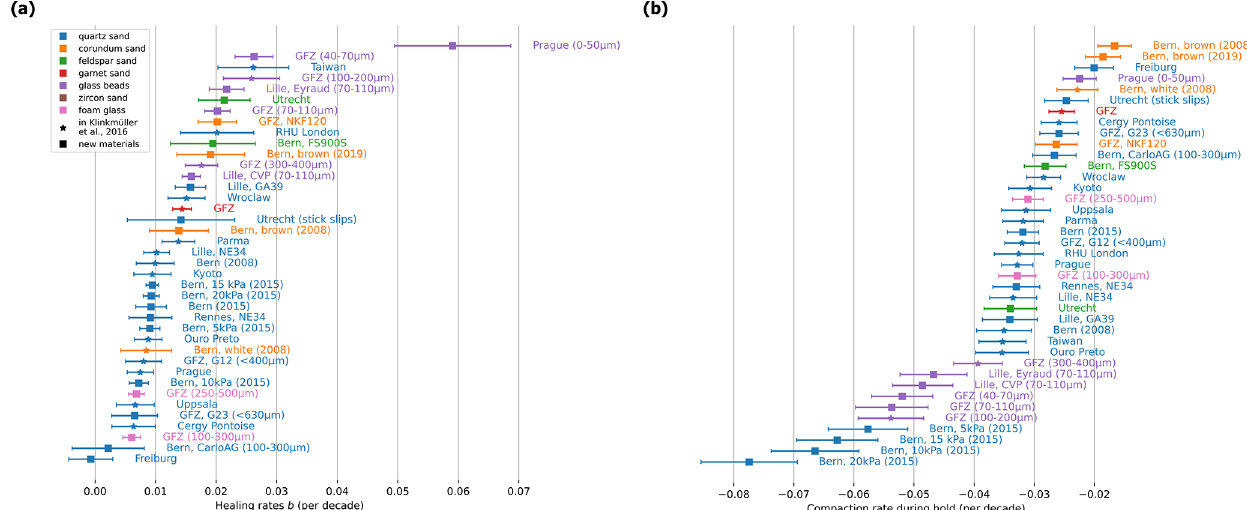
Figure 4. Stacked and sorted plot of (a) healing rates and (b) compaction rates for all tested materials. The numbers either indicate grain size range (e.g. Prague 0–50µm), type (e.g. G23) or year of acquisition (e.g. Bern, brown 2019). Similar materials often plot in the same range of healing or compaction rate. Notable exceptions are the healing rate for very fine glass beads (Prague, 0–50µm) and the compaction rates for higher normal stresses (Bern, 5–20kPa).